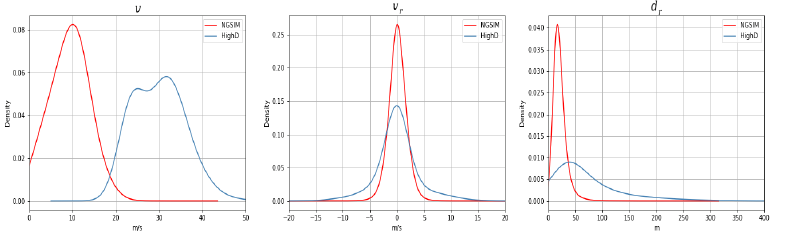
Figure 4. An illustration of car-following case. HV denotes a host vehicle. BV denotes a back- ground vehicle.